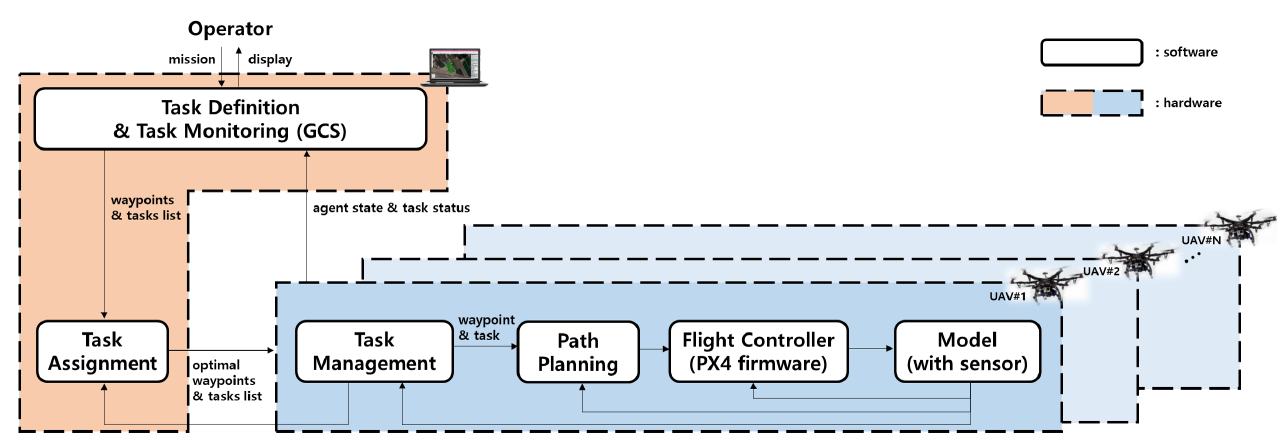
Figure 1. System